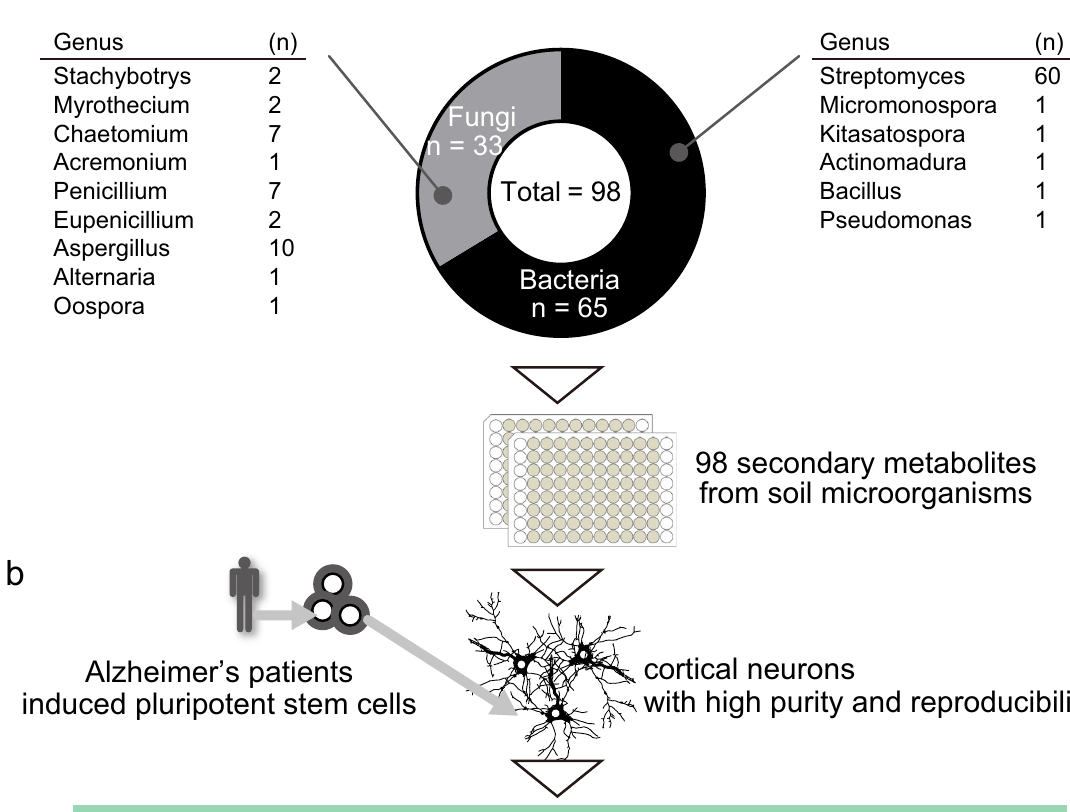
Figure 1. Screening system to evaluate compounds originating from soil microbiota. ( a ) Extraction and purification of compounds originating from soil microbiota. ( b ) Schema of study design and compound library from soil